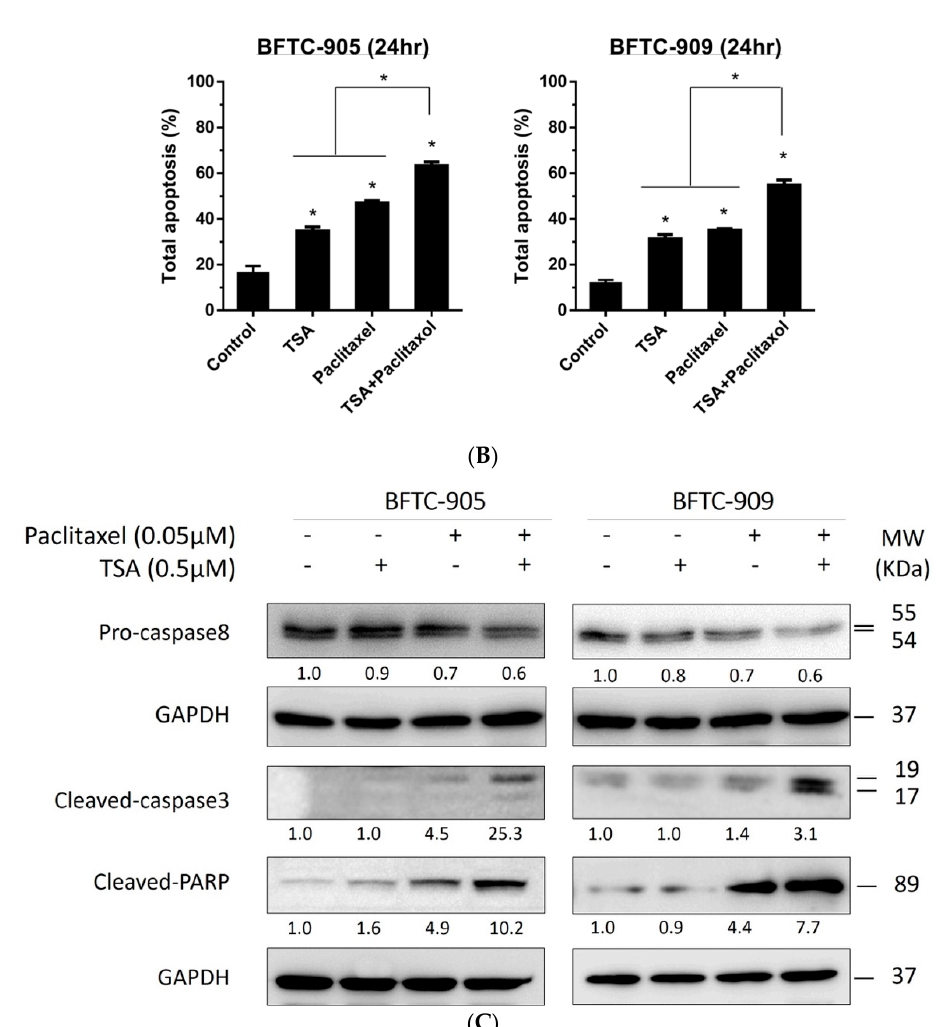
Figure 2. Flow cytometry analysis and apoptosis signaling transduction with TSA,